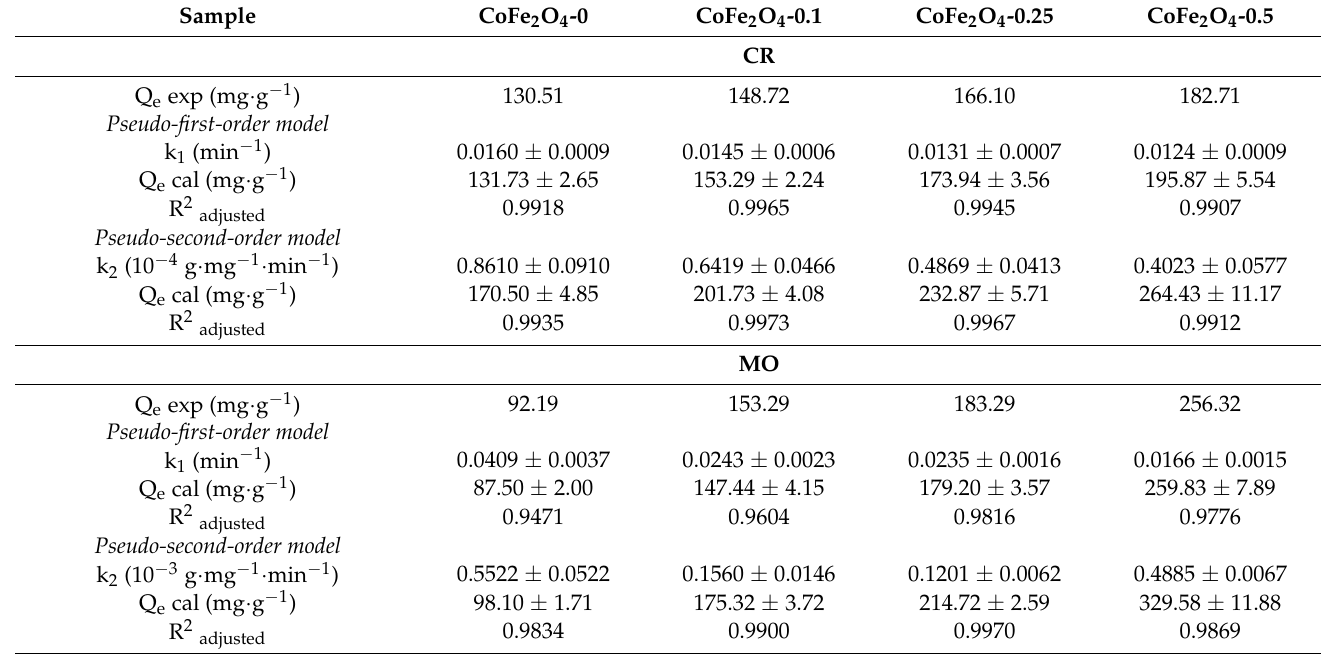
Table 3. ThekineticparametersfordyesadsorptionontoCoFe 2 O 4 samplesfromsinglecomponentsolutions(nonlinearregression).